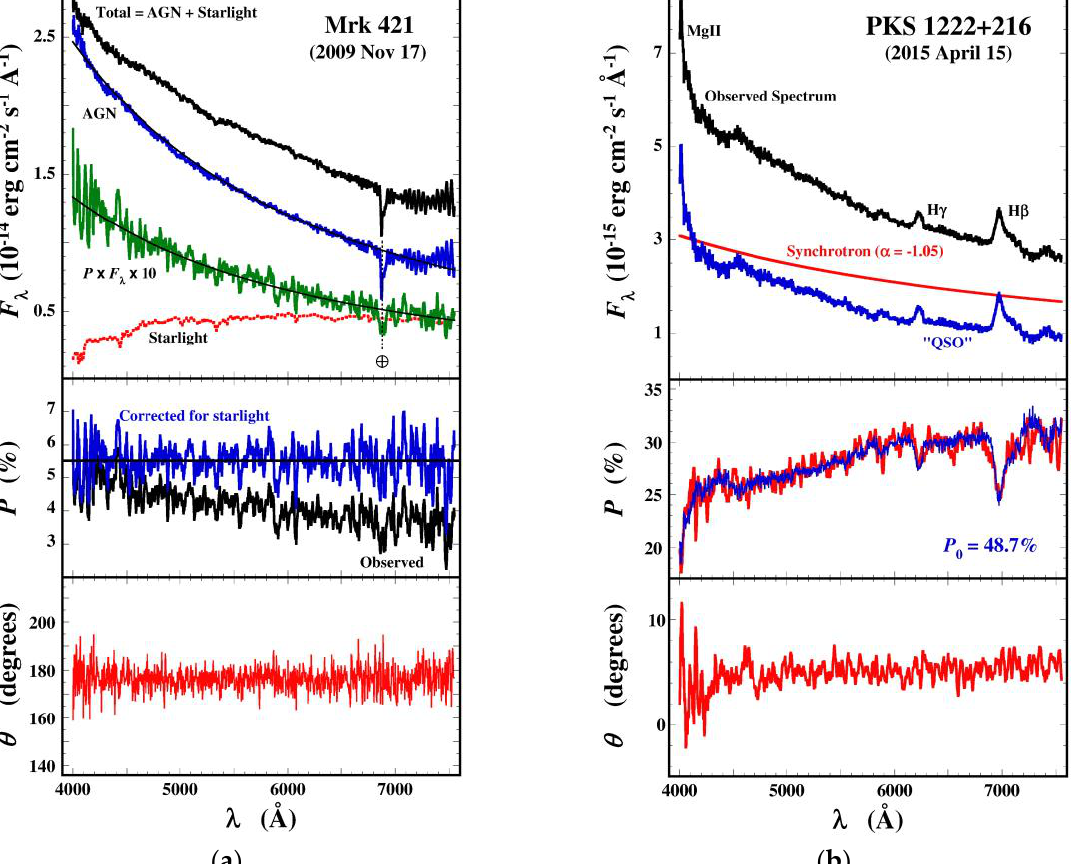
Figure 4. ( a ) Decomposition of the optical spectrum of Mrk 421 into active galactic nuclei (AGN) and host galaxy components. The model assumes that the intrinsic polarization of the blazar is ~5.5% and that it is constant with wavelength. The polarized flux spectrum (green) has been scaled up by a factor of 10 for clarity; ( b ) Spectral decomposition of PKS 1222+216 into a polarized power-law continuum from the blazar jet and an unpolarized blue continuum plus broad emission-line region similar to a QSO. The model (blue curve in the middle panel) satisfactorily reproduces the decreases in polarization observed at the wavelengths of emission lines and in the continuum toward the blue end of the spectrum. An intrinsic polarization of nearly 49% is implied for the optical synhcrotron emission. If correct, this would be the highest level of polarization seen in a blazar to date.